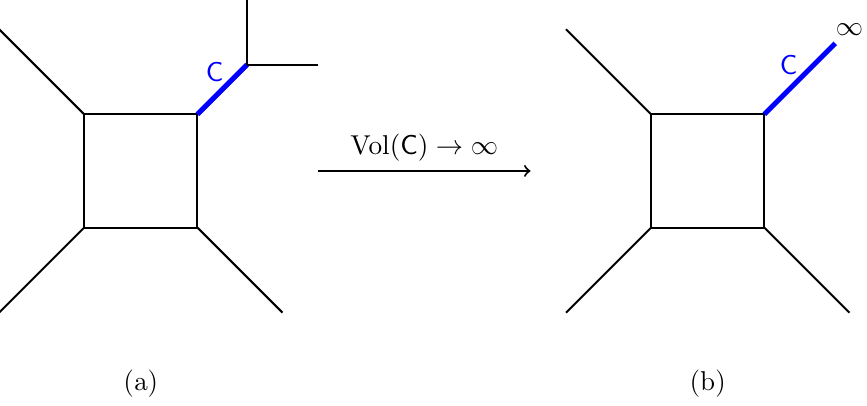
Figure 3 . Toric diagrams of local P 1 × P 1 blowup at one point. (a) is a star triangulation of the polygon commonly used in the mirror symmetry. (b) is a flop transition of (a).